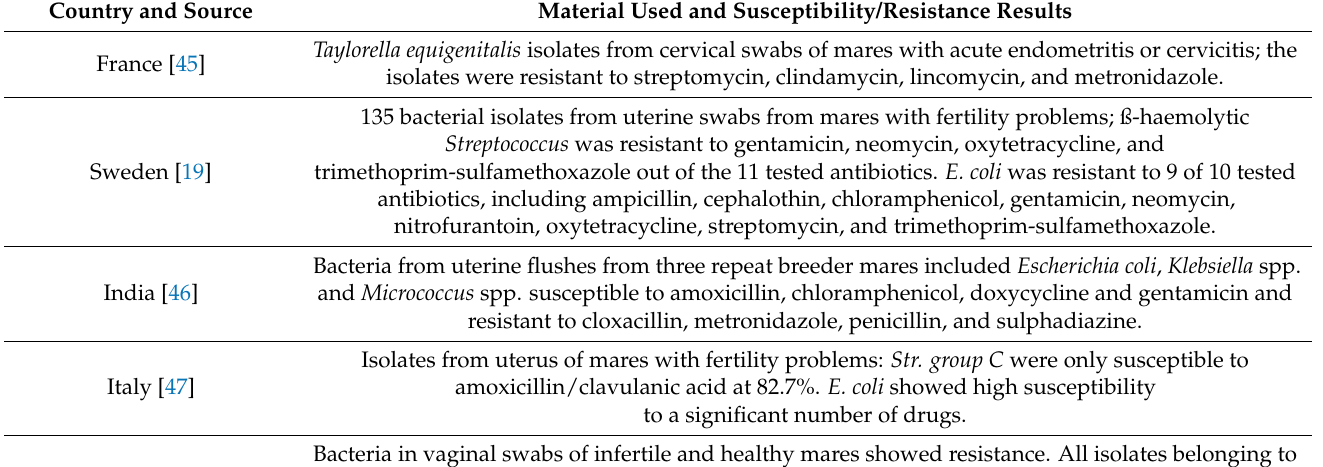
Table 1. Summary of antimicrobial resistance patterns in the equine reproductive tracts in various countries. Country and Source Material Used and Susceptibility/Resistance